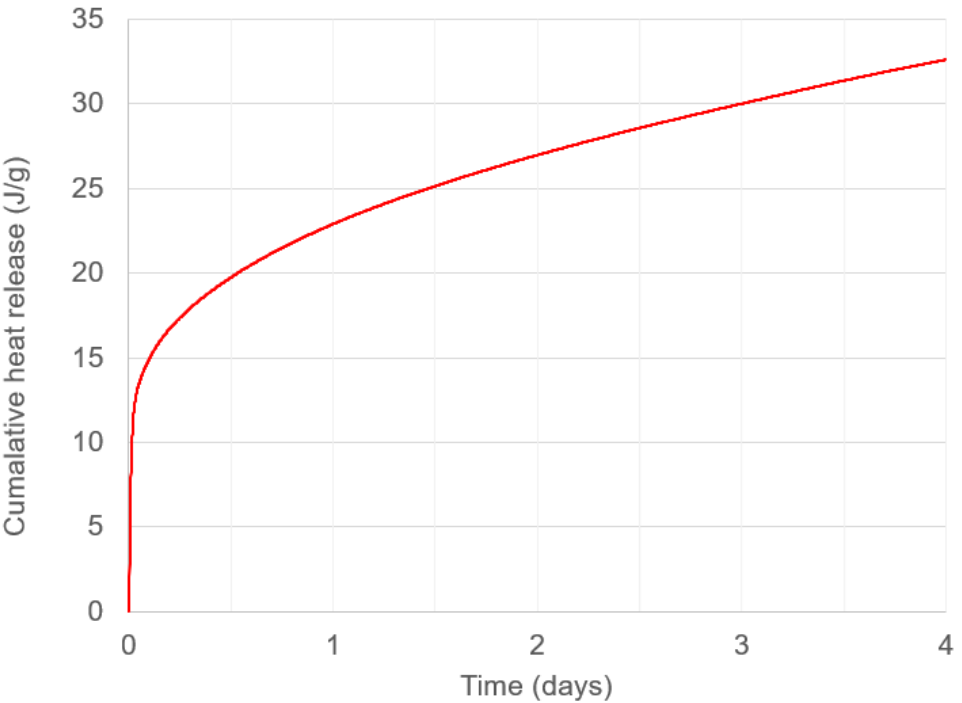
Figure 11. Cumulative heat release of geopolymer binder over 4 days.